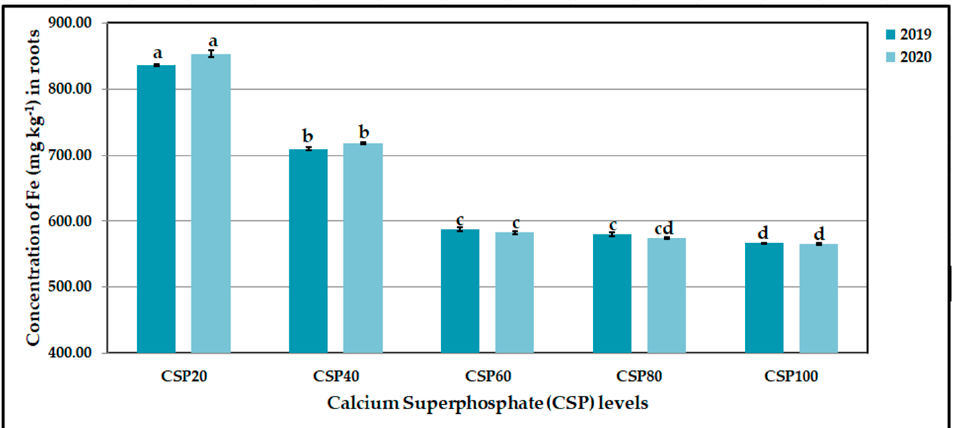
Figure 9. Influence of calcium superphosphate (CSP) levels on root iron (Fe, mg kg − 1 ) contents of CaCO 3 ‐ stressed sweet potato plants in 2019 and 2020 seasons. Bars with a different letter indicate significant difference between treatments at p ≤ 0 .05. CSP 20 , CSP 40 , CSP 60 , CSP 80 , and CSP 100 represent CSP added as a soil application at 69, 138, 207, 276, and 345 kg ha − 1 , respectively.